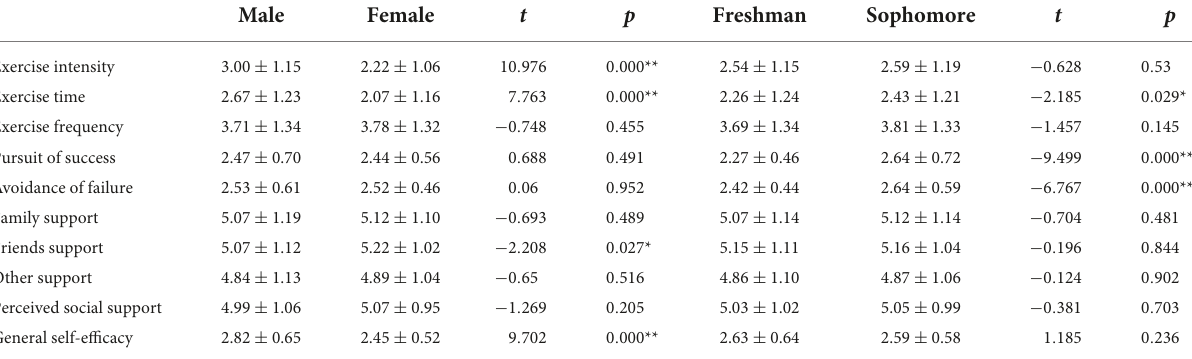
TABLE 2 Demographic difference of each variable and its different dimensions.